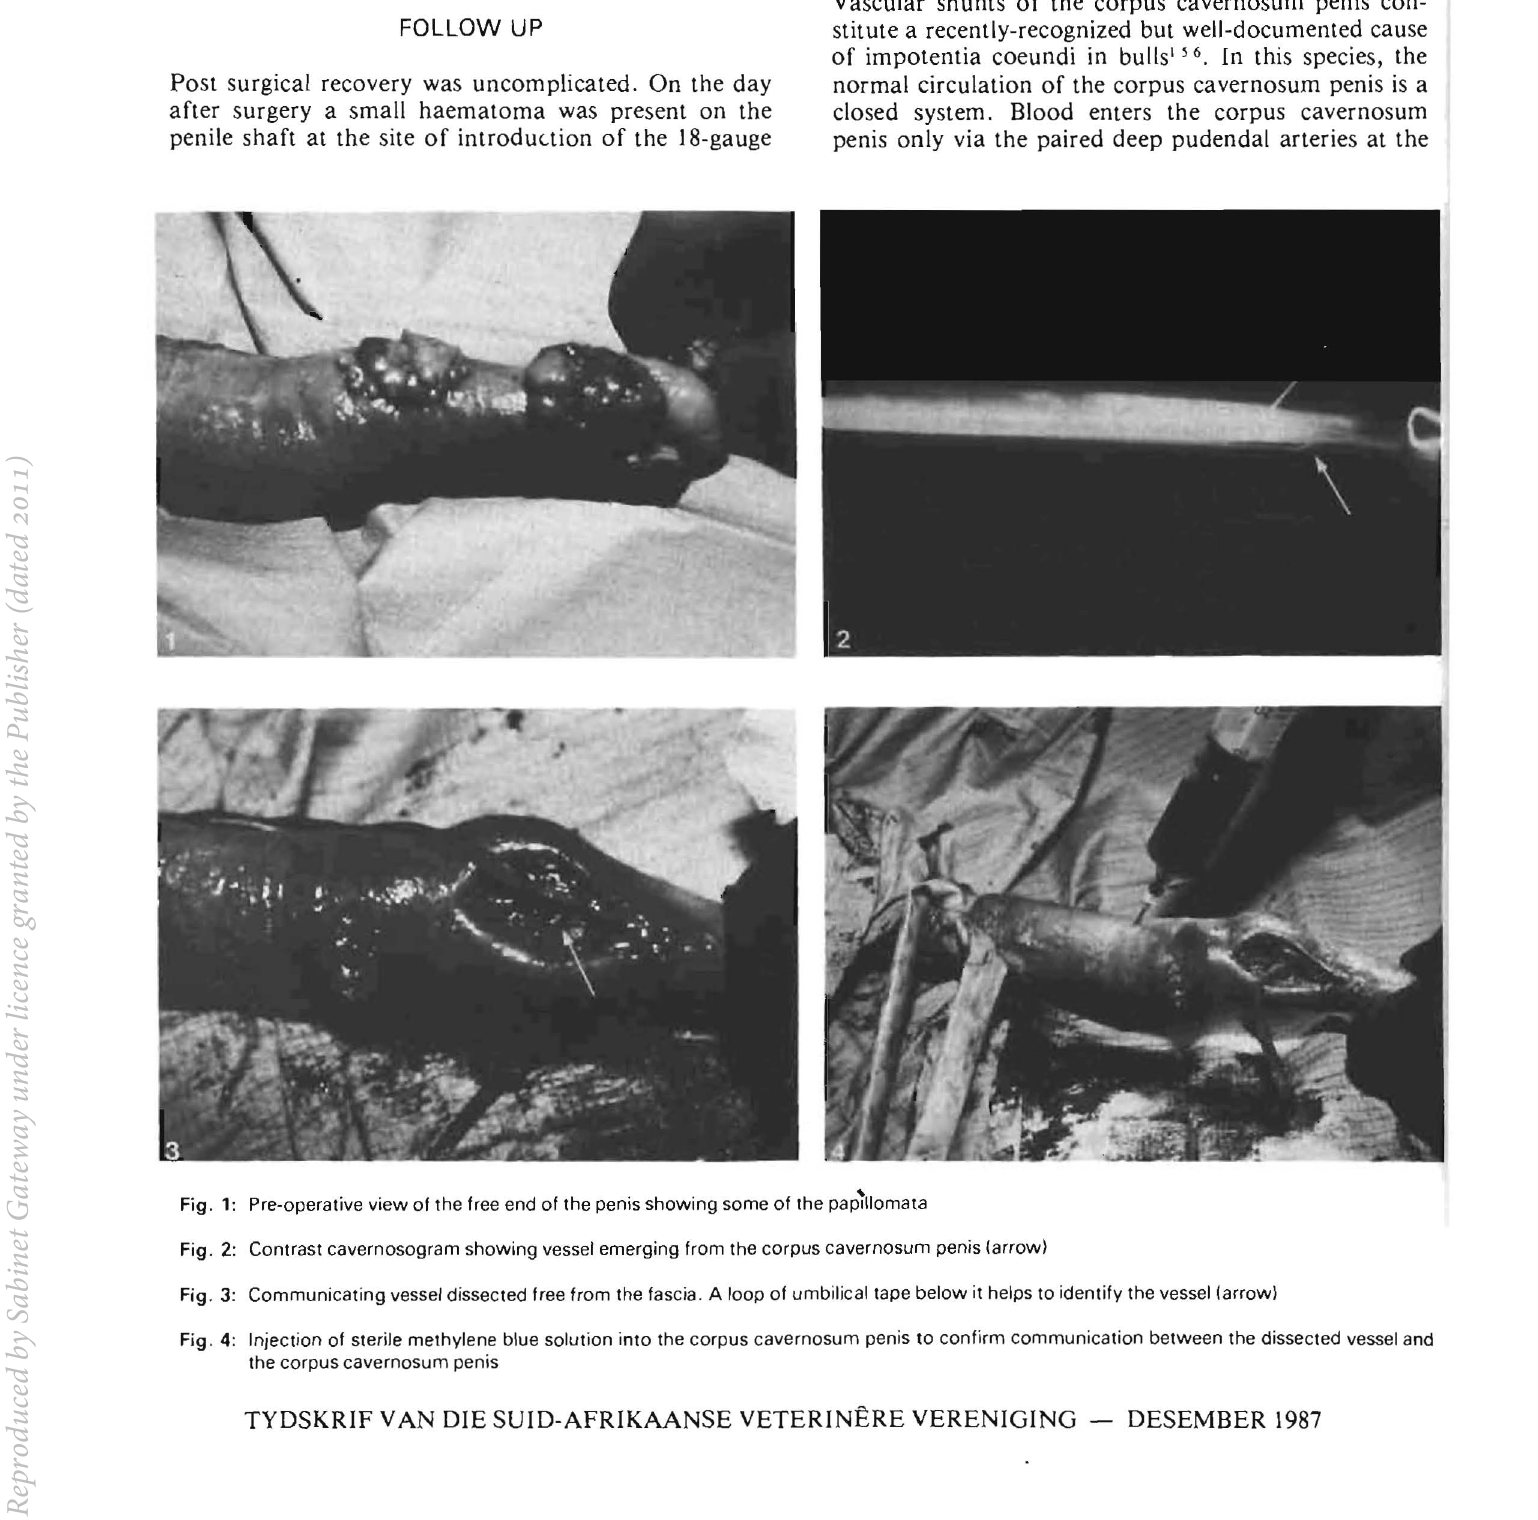
Fig. 1: Pre·operative view of the free end of the penis showing some of the pap~lIomata Fig. 2: Contrast cavernosogram showing vessel emerging from the corpus cavernosum penis (arrow) Fig. 3: Communicating vessel dissected free from the fascia. A loop of umbilical tape below it helps to identify the vessel (arrow) Fig. 4: Injection of sterile methylene blue solution into the corpus cavernosum penis to confirm communication between the dissected vessel and the corpus cavernosum penis TYDSKRIF VAN DIE SUIO-AFRIKAANSE VETERINERE VERENIGING